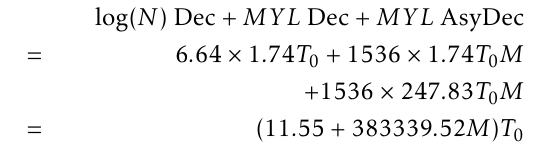
Figure 16. The figure shows the total computational load for all users under GroupIt and the proposed protocol versus the number of devices in a DG for the case when a user leaves SG x